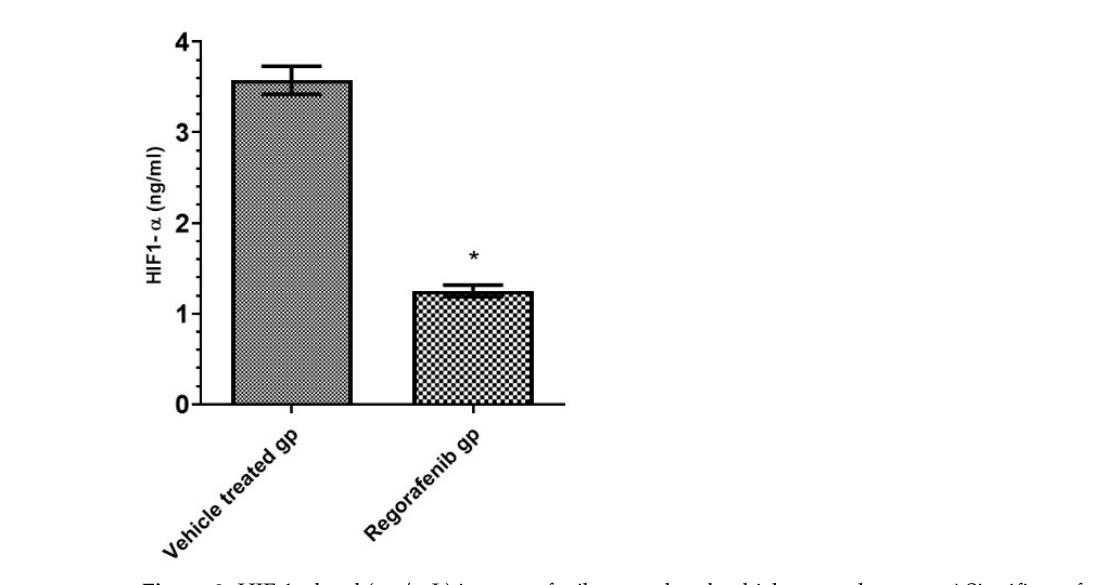
Figure 2 . HIF-1 α level (ng/mL) in regorafenib-treated and vehicle-treated groups. Figure 2. HIF-1 α level (ng/mL) in regorafenib-treated and vehicle-treated groups. * Significant from control group at p < 0.05.